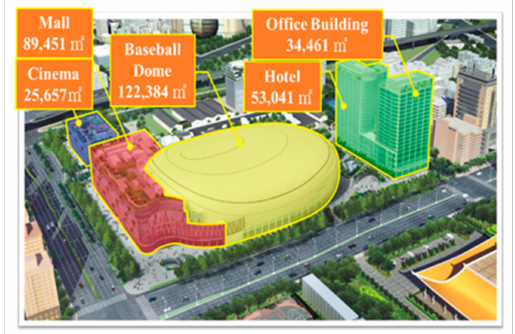
Figure 2. Distribution of